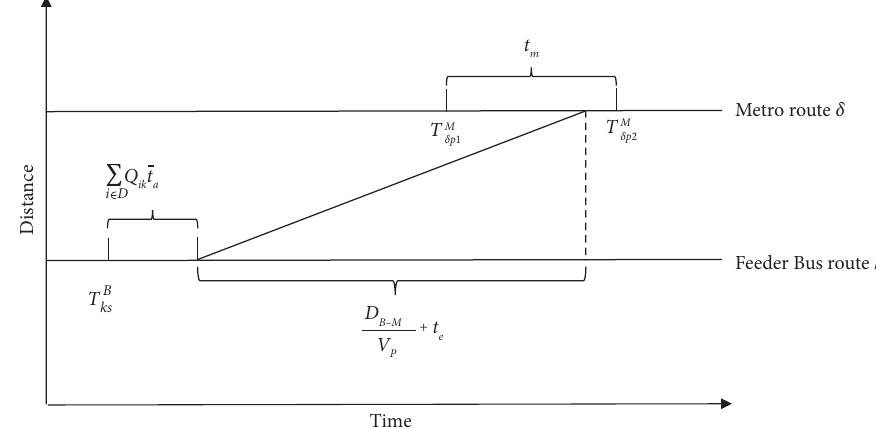
Figure 1: Time-space diagram of the feeder bus to the